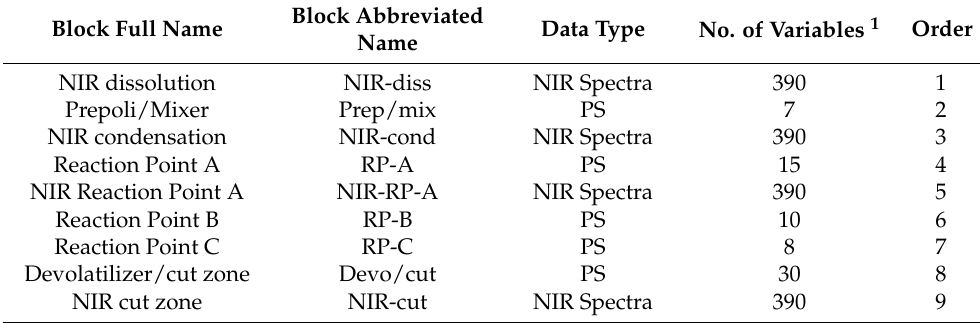
Table 1. Data block description.